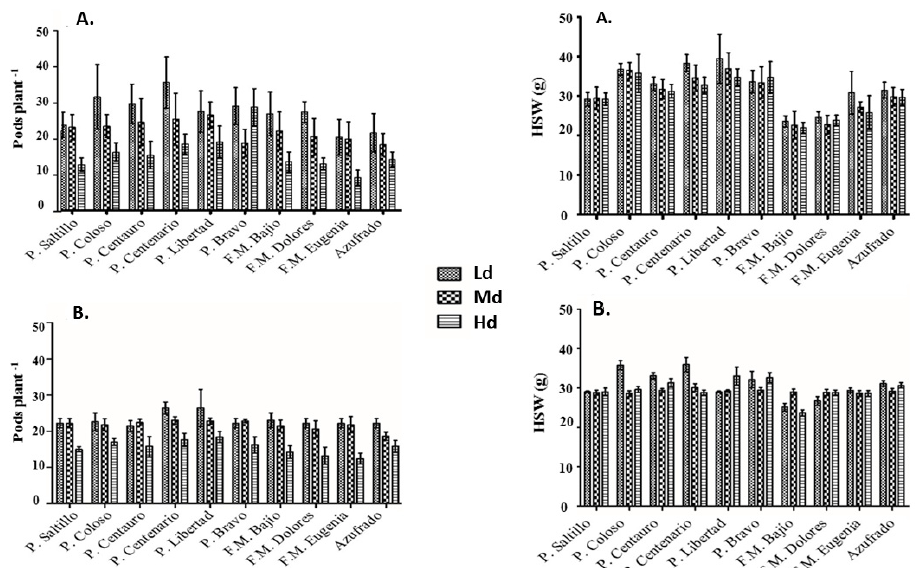
Figure 3. Number of pods per plant and hundred seed weight (HSW) of ten dry bean ( Phaseolus vulgaris L.) cultivars established at 90,000 plants ha − 1 (Low density, Ld), 145,000 plants ha − 1 (Medium density, Md) and 260,000 plants ha − 1 (High density, Hd) under rainfed conditions, with 175 mm ( A ) and 492 mm ( B ) of precipitation during the 2011 and 2013 growing seasons in Pabellon de Arteaga, Aguascalientes, Mexico. The standard error of the mean of five plants for number of pods per plant and the mean of five plots for HSW is indicated by the vertical bars.